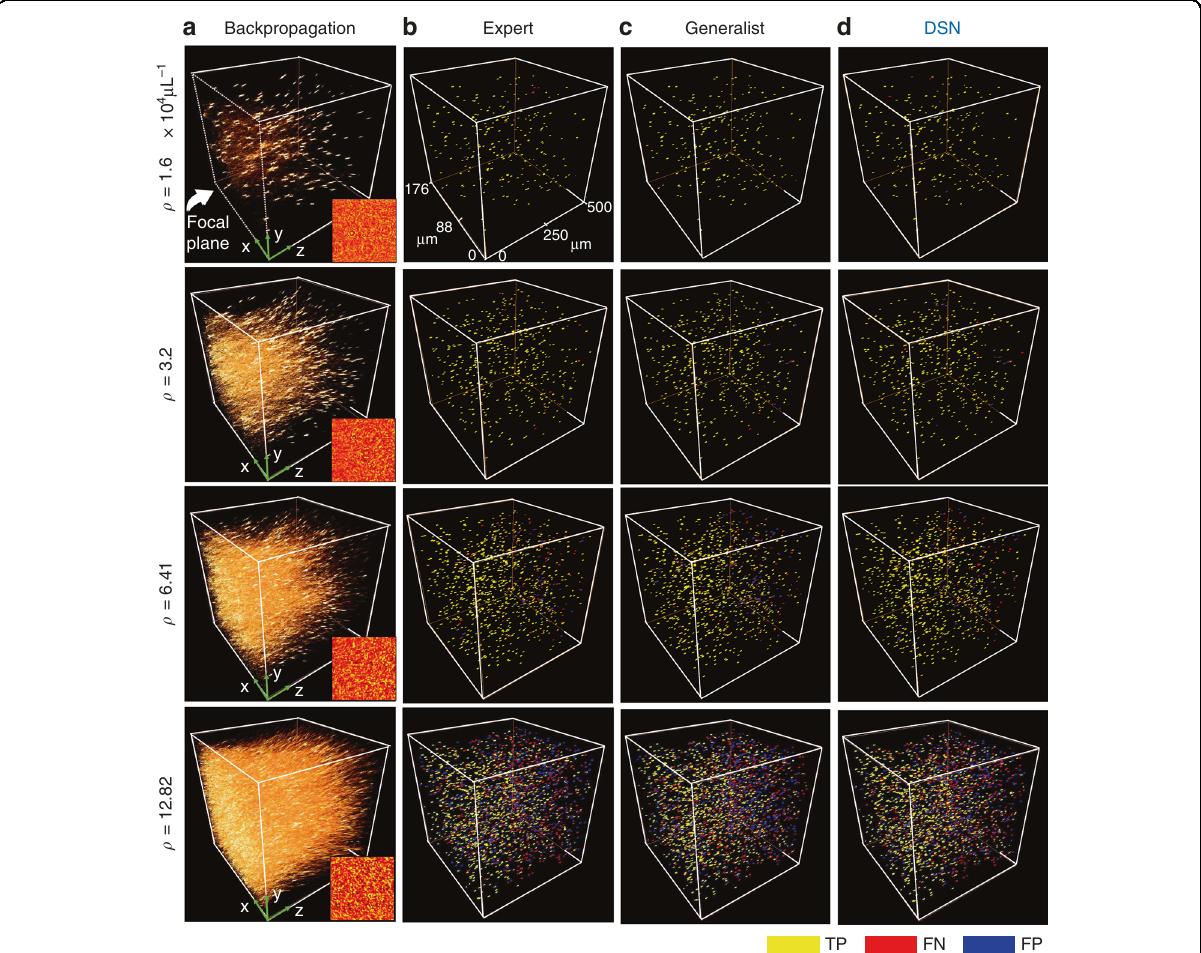
Fig. 2 Particle localization visualization. a 3D renderings of the backpropagated volumes demonstrate the scattering artifacts for various particle densities. The corresponding hologram is shown as the insets. b – d Particle 3D localization results are shown for the expert, generalist and DSN, respectively. For low particle densities, all three DNNs perform similarly. As the particle density increases, the DSN provides improved performance, measured by the true positives (TP, in yellow), false negatives (FN, in red), and false positives (FP, in blue). The numbers of TP, FP, and FN are quanti fi ed in Table S1, highlighting that the results from the DSN contain much fewer FPs at high particle density